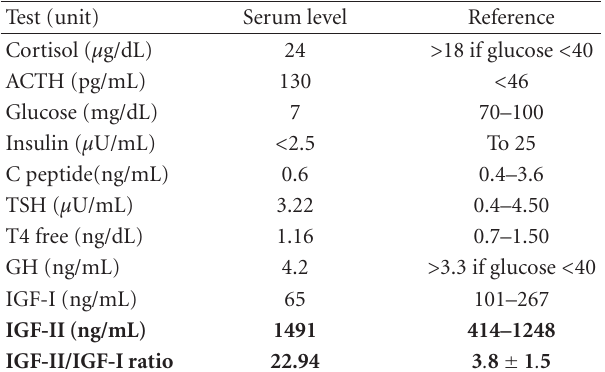
Table 1: Laboratory tests.